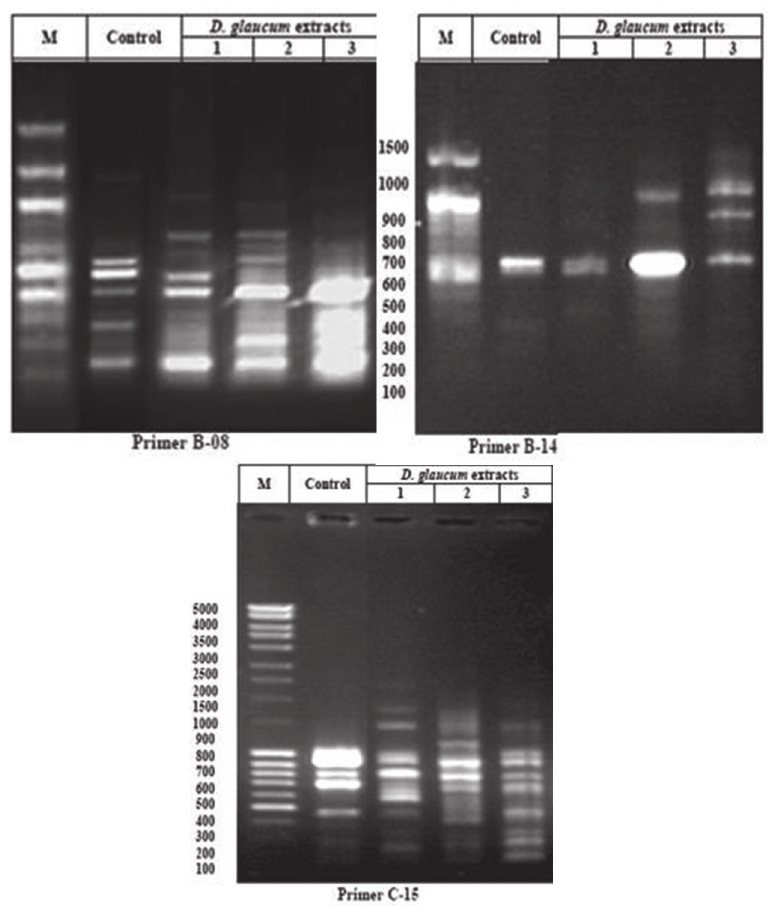
Figure 4 - RAPD amplified products of Vicia faba treated with three D. glaucum extracts using three random primers. 1. Water extract, 2. Ethanol extract, 3. Ethyl acetate